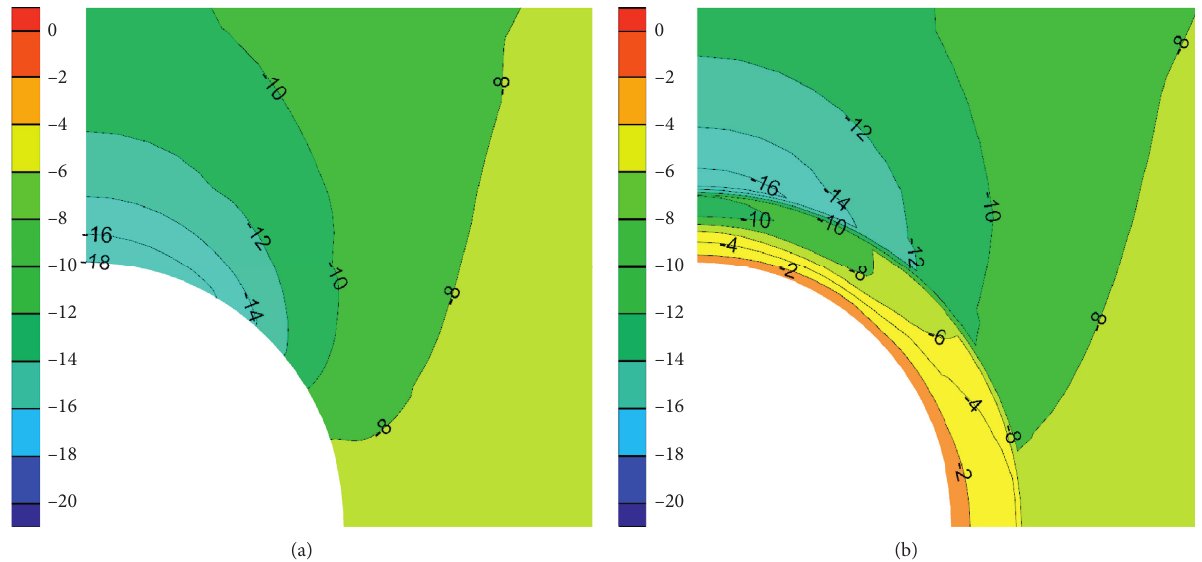
Figure 17: The distribution of shear stress of surrounding rock around shaft (depth � 300m, unit: MPa) (a) No damage zone included. (b) Damage zone